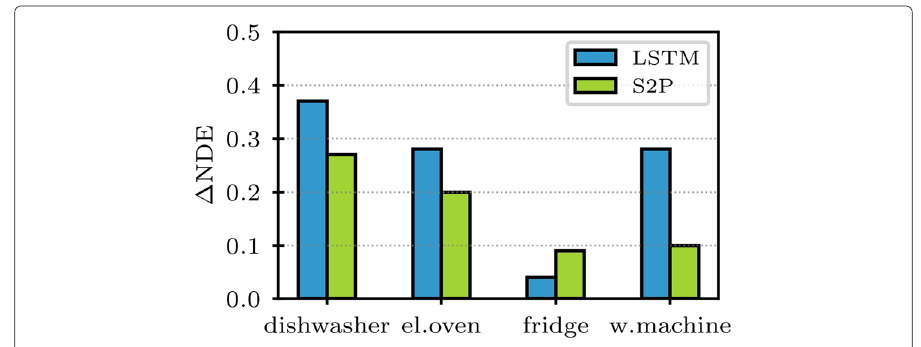
Fig. 6 Performance gap with regard to NDE for UK-DALE house 5